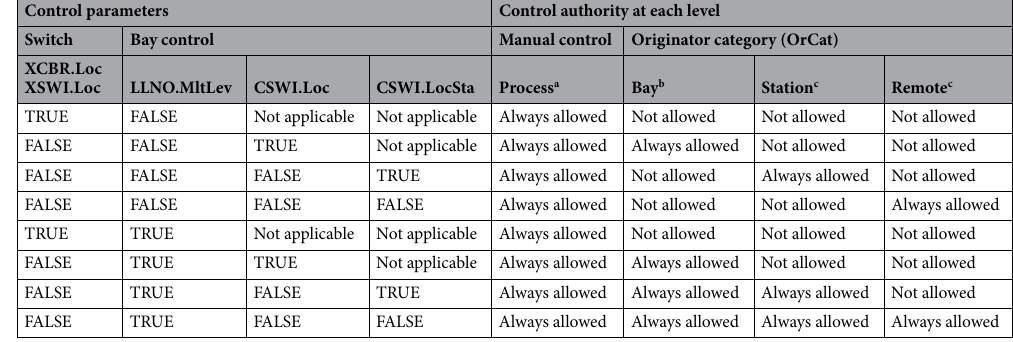
Table 3. Switchgear control based on control authority 6 . a Current and voltage transformers (CT/VT) connected to MU. b Switch controller communicating at process level with MU via SV and CB via GOOSE and MMS. c Communication with switch controller via